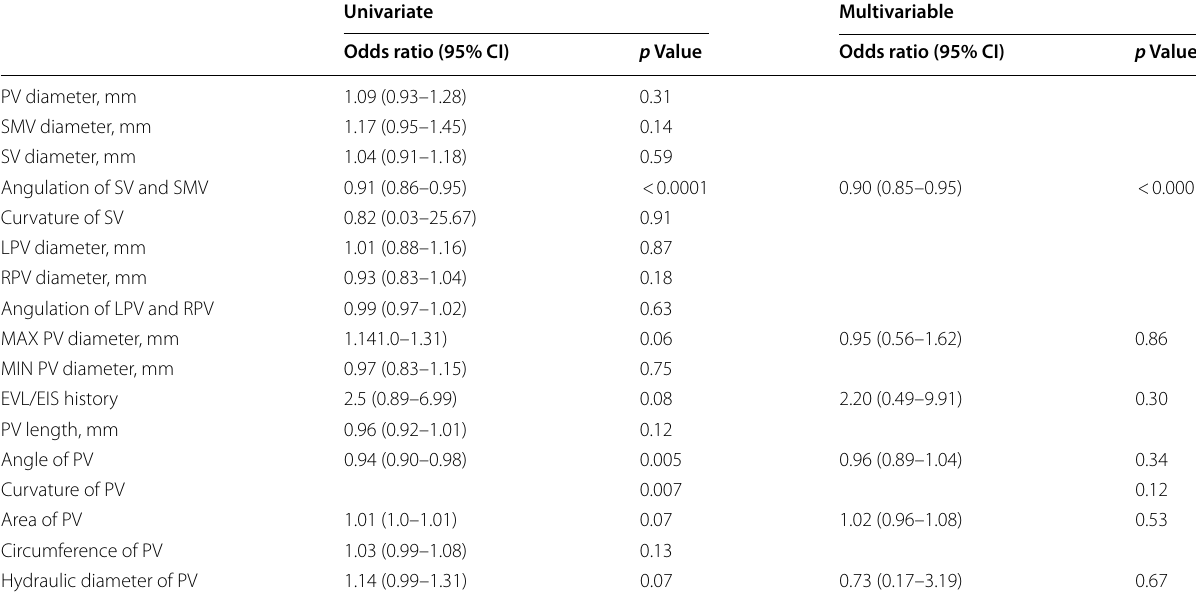
EVL, endoscopic variceal ligation; EIS, endoscopic injection sclerotherapy